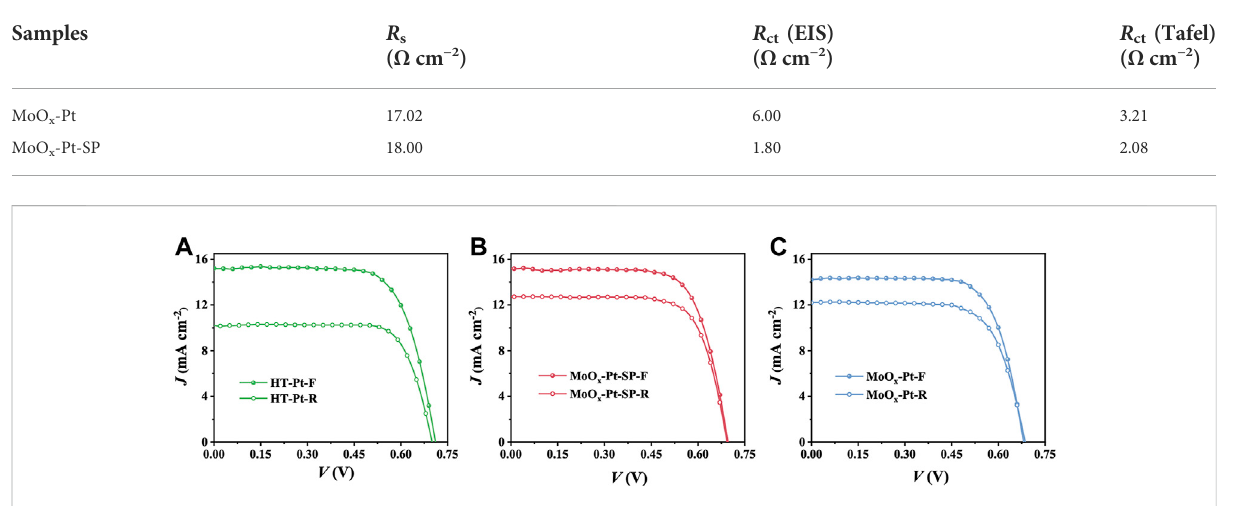
FIGURE 5 J – V curvesofDSCswithHT-Pt (A) ,MoO x -Pt-SP (B) ,andMoO x -Pt (C) CEsmeasuredunderAM1.5G100 mW cm − 2 fromthefront(F)andrear(R)